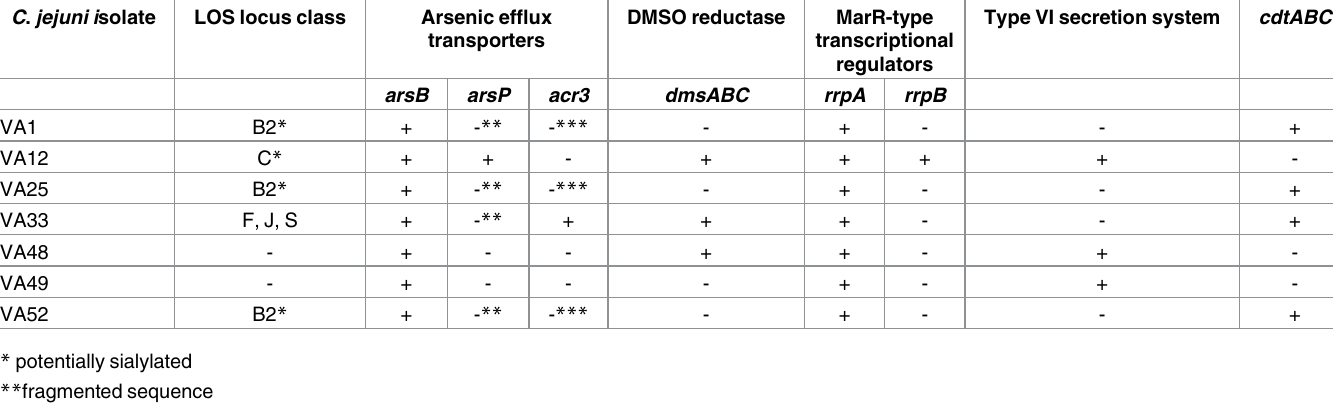
Table 2. LOS locus classesand putative virulence factors detected among the C. jejuni water isolates. C . jejuni i